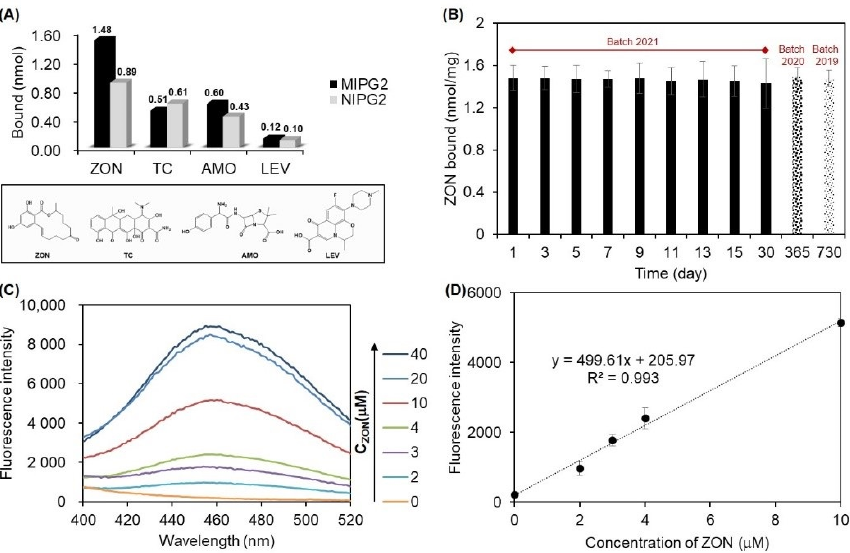
Figure 2. ( A ) Selectivity test of 1 mg MIPG2 and NIPG2 towards ZON and three structurally similar reagents tetracycline (TC), amoxicillin (AMO), and levofloxacin (LEV) at 2.5 µ M, respectively. The chemical structure of three structurally similar reagents are given below. ( B ) Detection record of 1 mg MIPG2 (of the same batch) towards 2.5 µ M ZON during 30 days after each template extraction, as well as 1 mg MIPG2 (of a different batch) towards 2.5 µ M ZON in 1 and 2 years, respectively. ( C ) Analyte-dependent fluorescence emission spectra of MIPG2 with respect to ZON ranging from 0 to 40 µ M in corn juice. ( D ) Lear fitting plot of fluorescence intensity of MIPG2 towards ZON in corn juice. Corn juice tests were performed on glass substrates coated with MIPG2.